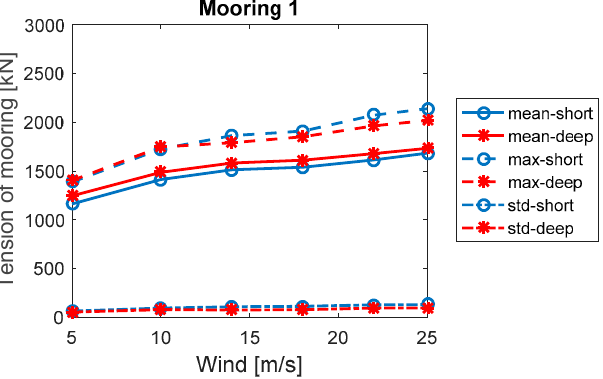
Figure 14. Statistics of the tension of Mooring Line 1 for the short spar and deep spar VAWTs.